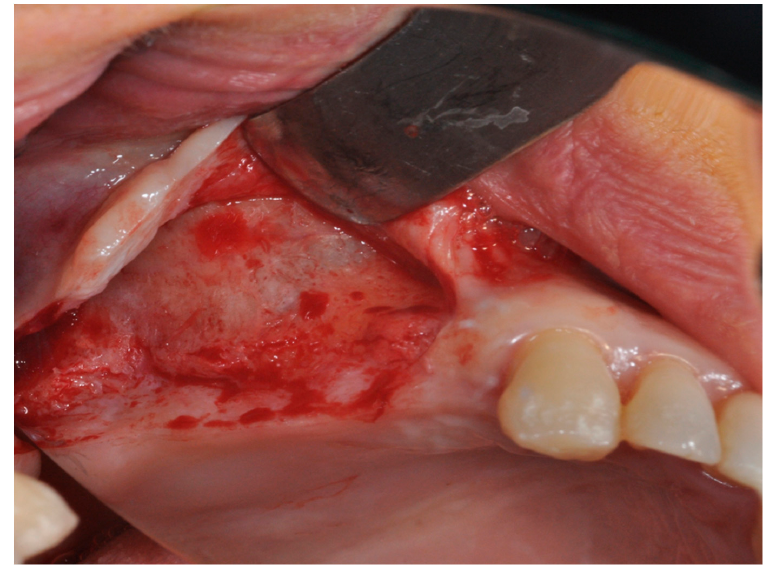
Figure 8. The modified triangular flap with a relieving incision in the distal region without a mesial relieving incision was performed.